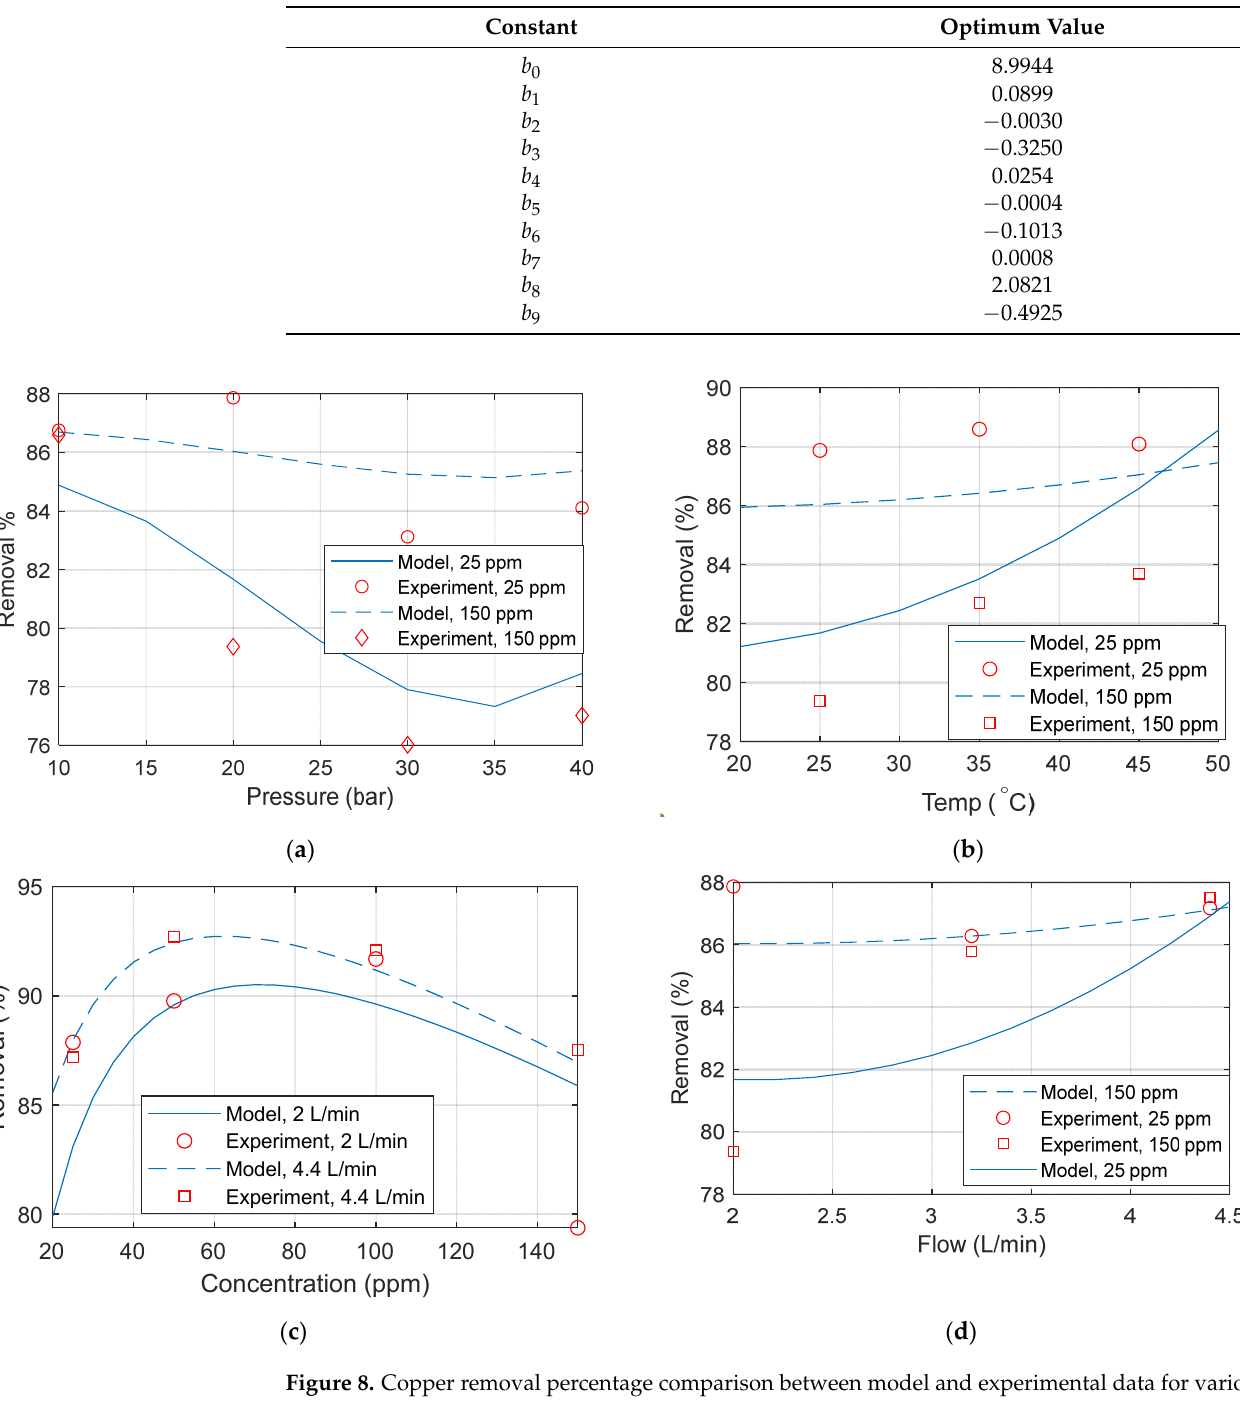
Figure 8. Copper removal percentage comparison between model and experimental data for various ( a ) pressure ( b ) temperature ( c ) concentration ( d ) flow rate.